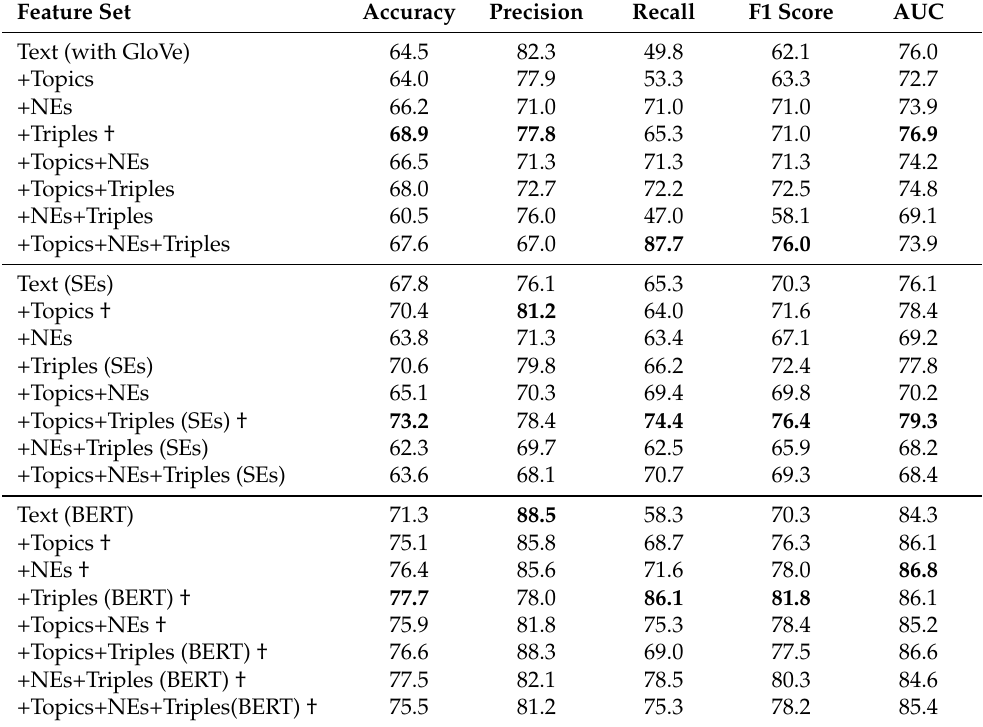
Table 2. News-feed classification results on the Energy-Hub dataset. †s indicate statistically sig- nificant differences (with McNemar’s test) with reference to the baseline model. For instance, the addition of triples improves the baseline mode (Text (with Glove)) from 64.5% to 68.9%, a difference that is statistically significant. Note: SEs = Sentence embeddings, NEs = Named